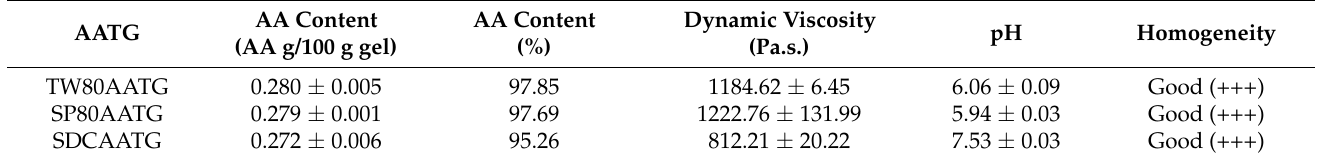
Table 1. The AA content, dynamic viscosity, pH and homogeneity of AA transfersomal gel formulations.